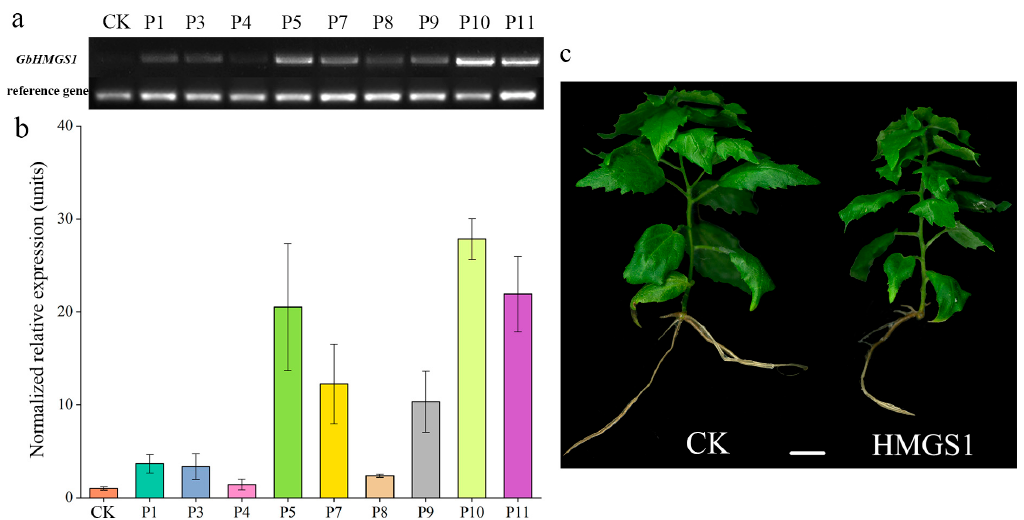
Figure 5. PCR analyses of transgenic lines. ( a ) and ( b ) Levels of GbHMGS1 expression in the nine transgenic lines and CK Populus determined by semiquantitative PCR and qRT-PCR, respectively. CK: nontransgenic plant; P1-P11: transgenic Populus plants. Each error bar indicates the standard error of the mean. ( c ) Phenotype of a 45-day-old CK poplar plant (left) and a poplar plant of GbHMGS1 line P10 (right). The scale bars represent 1.0 cm.